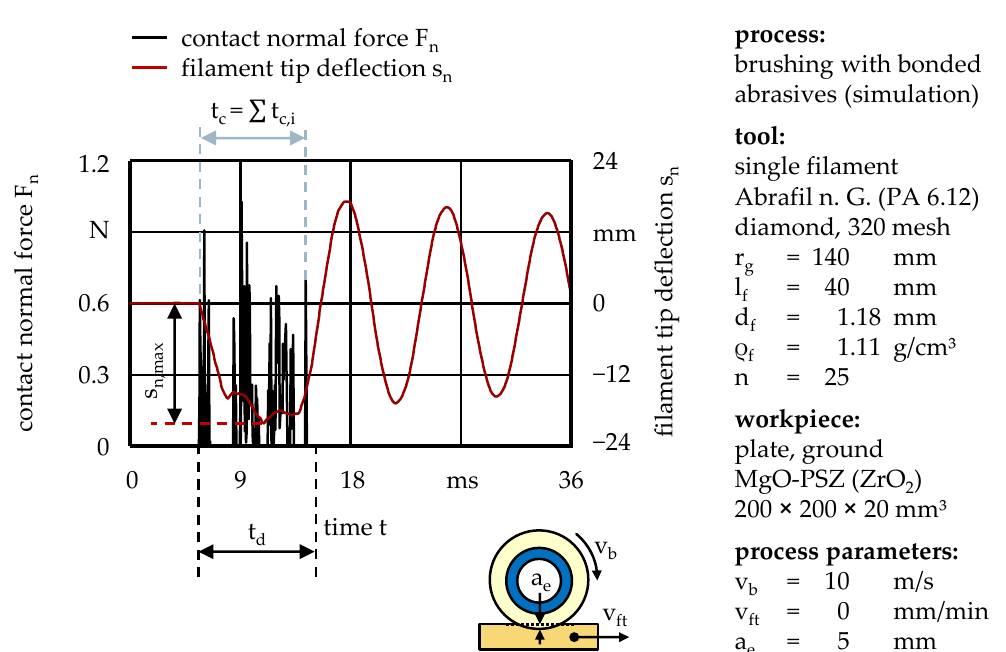
Figure 3. Contact normal force F n and filament tip displacement s n over time t.